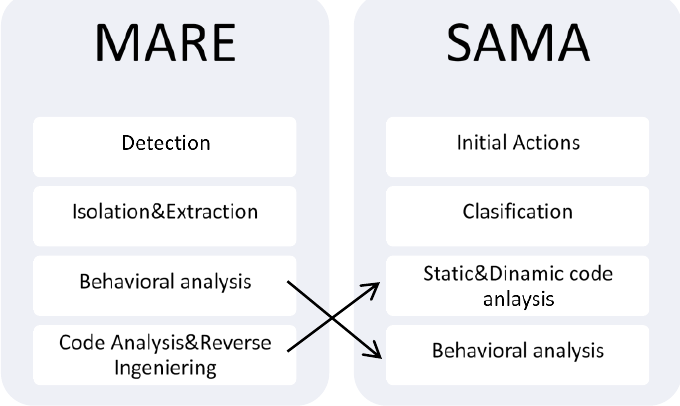
Figure 2. Di ff erences between the methodologies MARE and Figure 2. Differences between the methodologies MARE and SAMA.